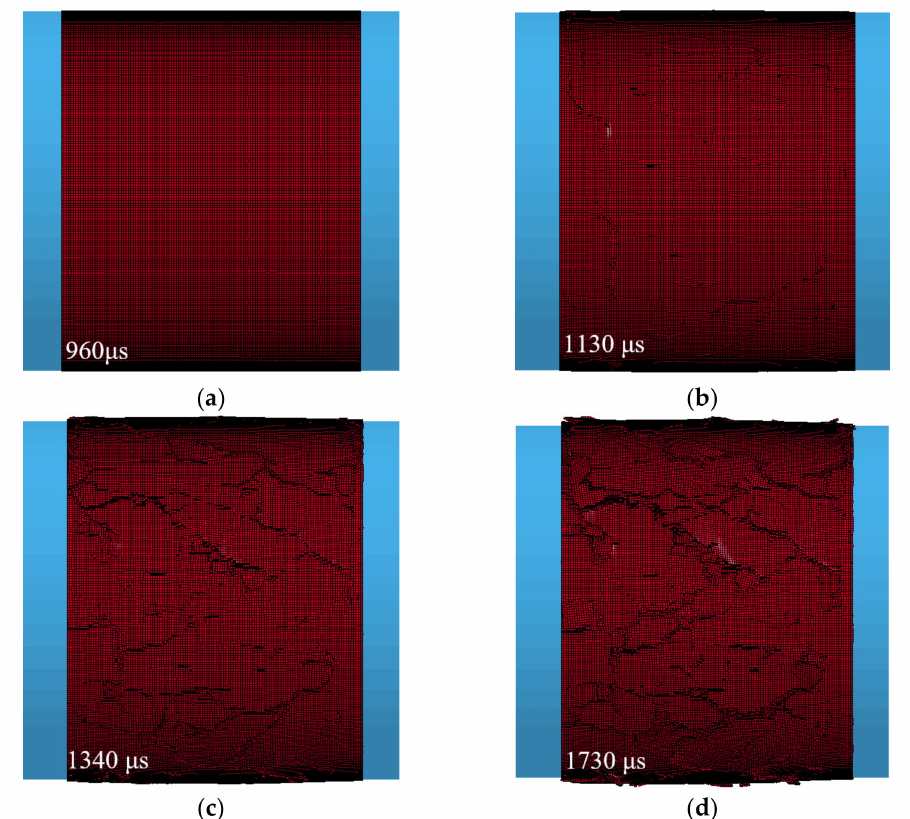
Figure 7. Deformation and failure process of concrete specimen at an impact velocity 15.33 m/s, ( a ) 960 µ s; ( b ) 1130 µ s; ( c ) 13400 µ s; ( d ) 1730 µ